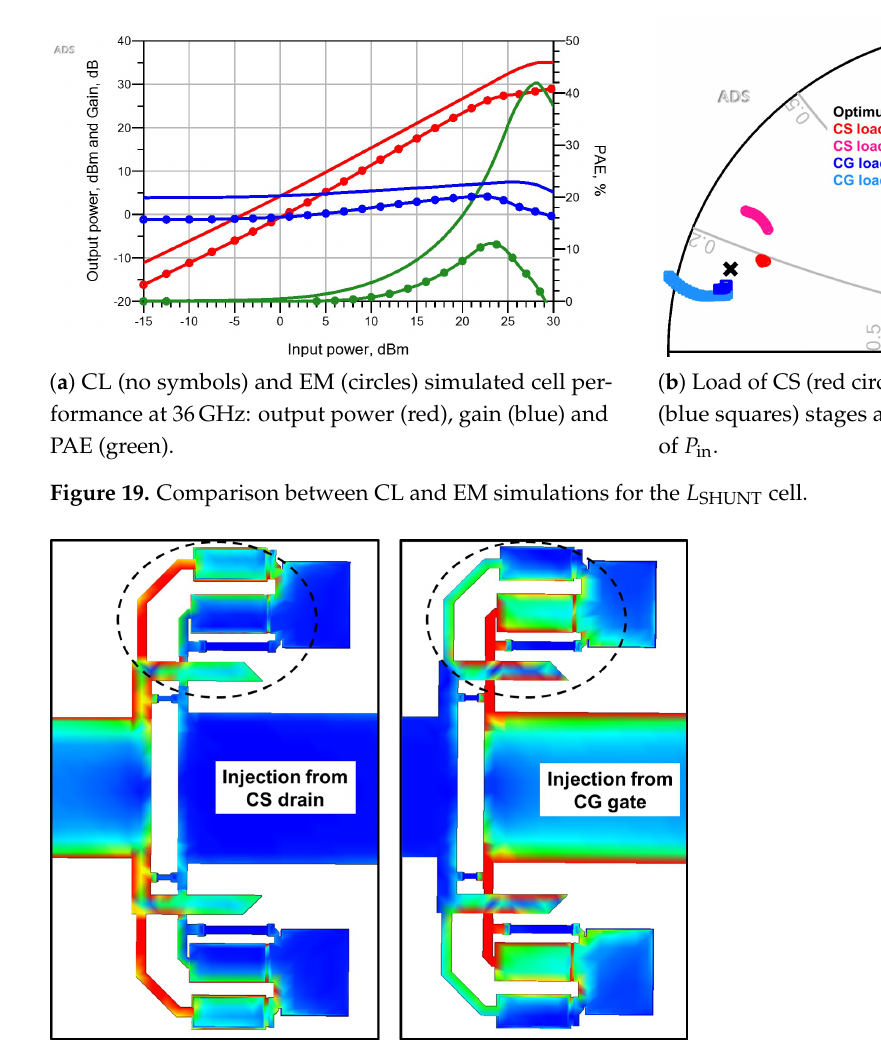
Figure 20. EM-simulated current densities in the L SHUNT cell. Blue to red means lowest to highest current